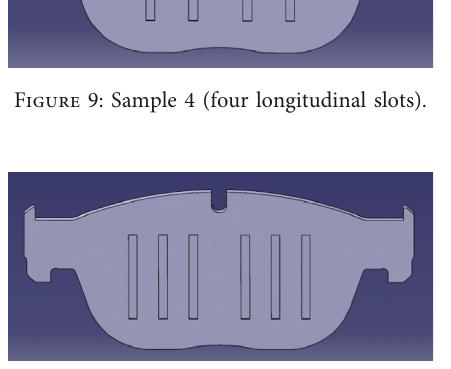
Figure 10: Sample 5 (six longitudinal slots).